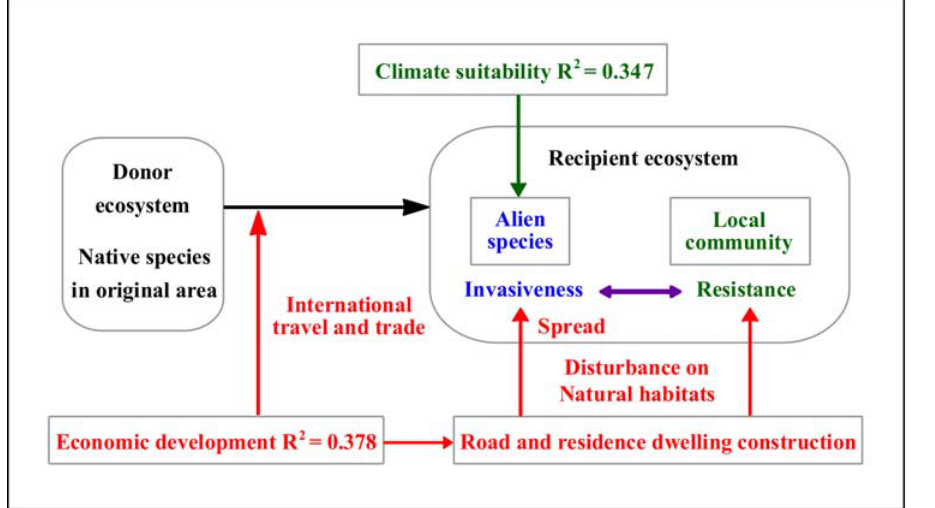
Figure 3. Relationship between biological, economical and climatic factors that determined the occurrence and spread of invasive species.